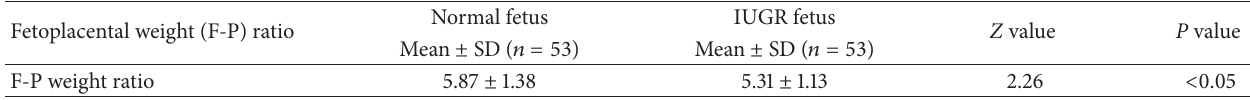
Table 6: The comparison of fetoplacental weight ratio in study groups.